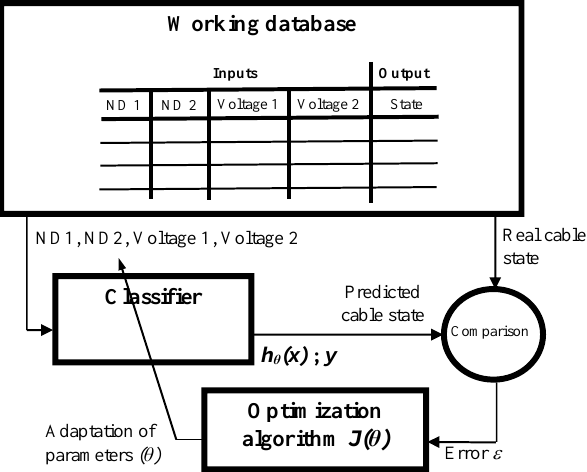
Figure 12. Classification process specified to logistic regression (LR) algorithm.